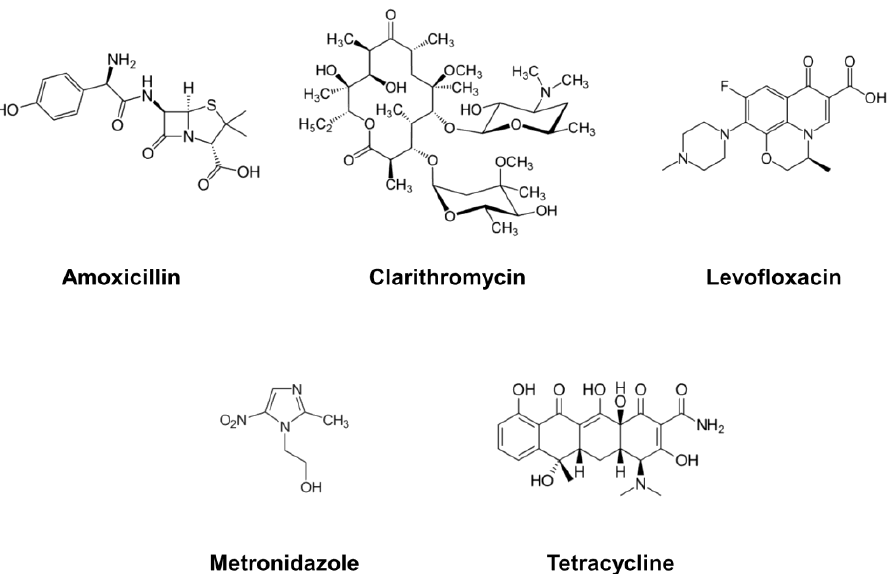
Figure 2. Structural formulas of the antibiotics used most frequently for the treatment of H. pylori infections. Amoxicillin, clarithromycin, levofloxacin, metronidazole, and tetracycline are shown.